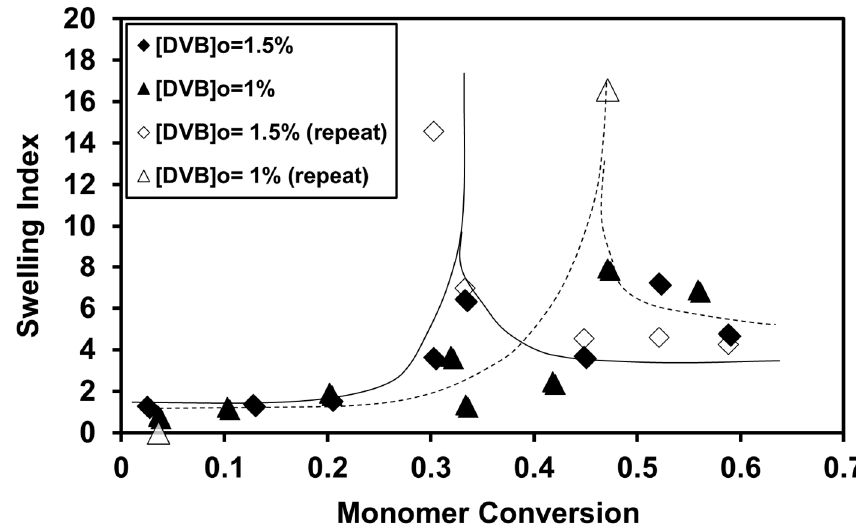
Figure 7. Effect of DVB content on the development of the SI for the NMC of STY/DVB in scCO 2 at [TEMPO]/[BPO] = 1.1, T = 120 °C, and P = 207 bar.